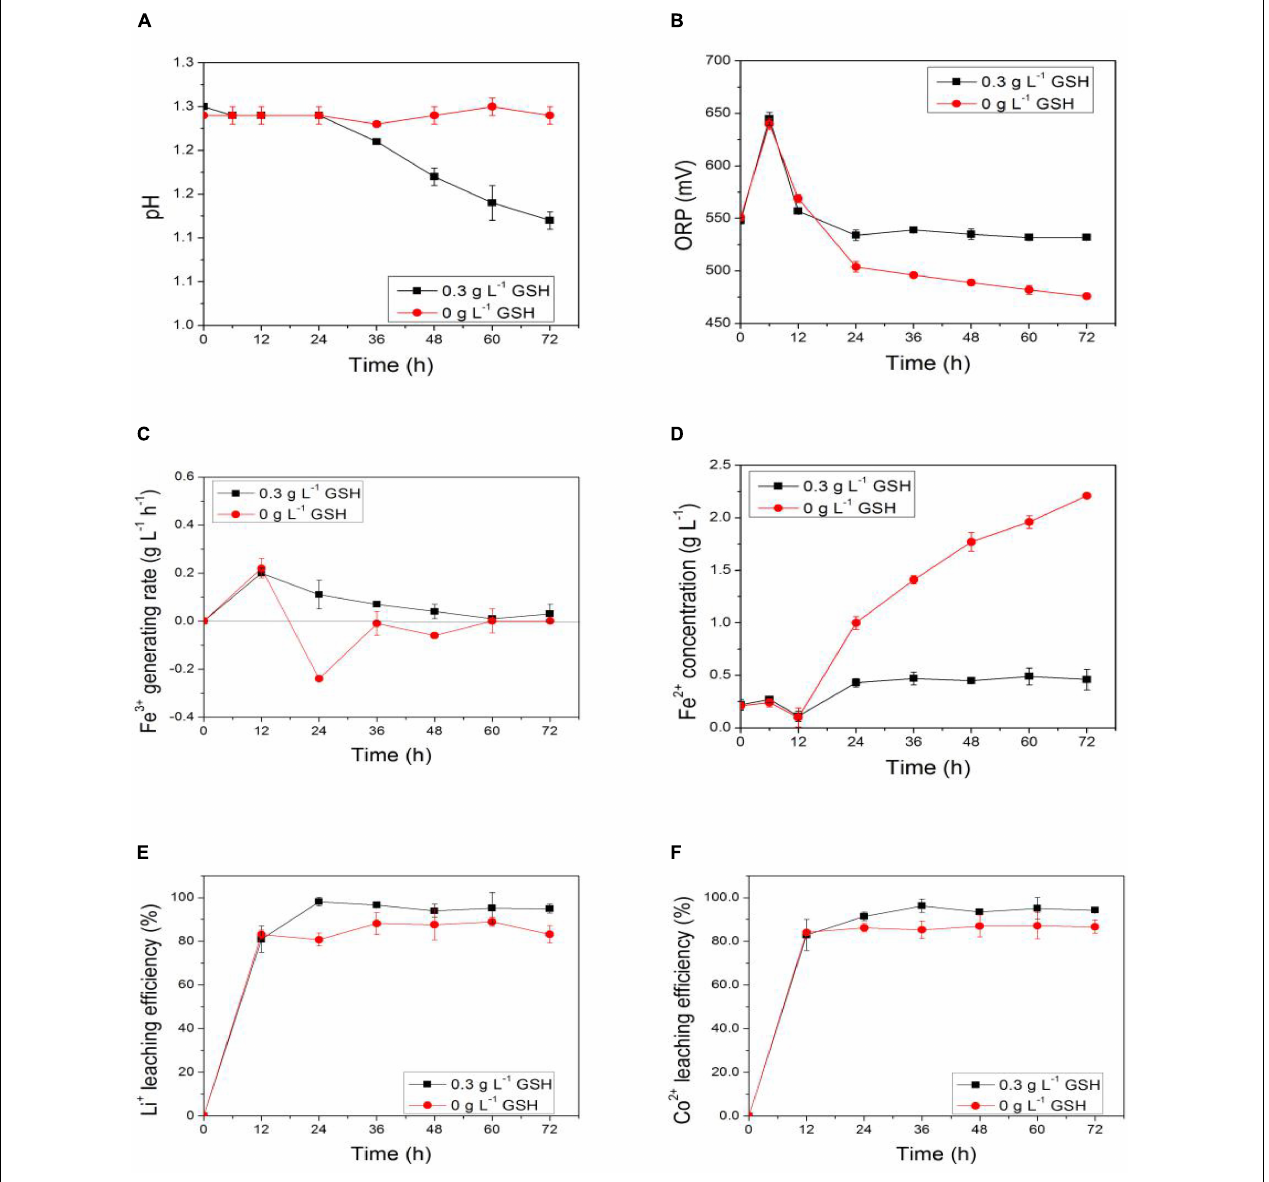
FIGURE 9 | Time-courses for (A) pH, (B) ORP, (C) Fe 3 + generation rate, (D) Fe 2 + concentration, (E) bioleaching efficiency of lithium, and (F) bioleaching efficiency of cobalt under pulp density of 5.0% with and without exogenous